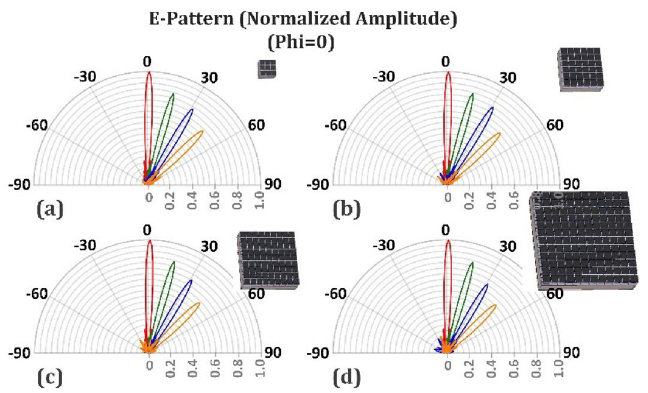
Figure 13. Variation of the radiated pencil beam for different reflectarrays composed of different cell-cluster dimensions. ( a ) Cell-cluster composed of 3 × 3 unit-cells. ( b ) Cell-cluster composed of 6 × 6 unit-cells. ( c ) Cell-